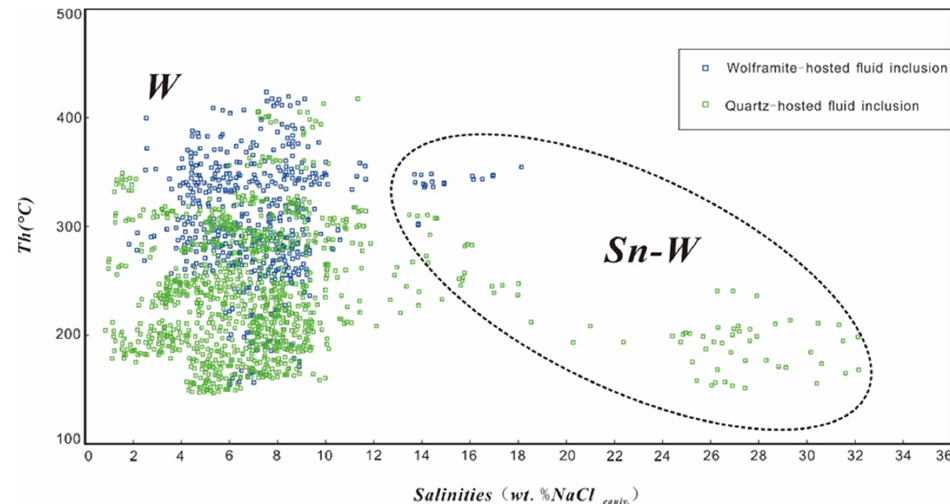
Figure 5. Homogenization temperature vs. salinity of fluid inclusions in wolframite and quartz from typical wolframite-quartz vein tungsten deposits worldwide. Note that higher salinity fluid inclu- sions are mostly found in Sn-dominated deposits.